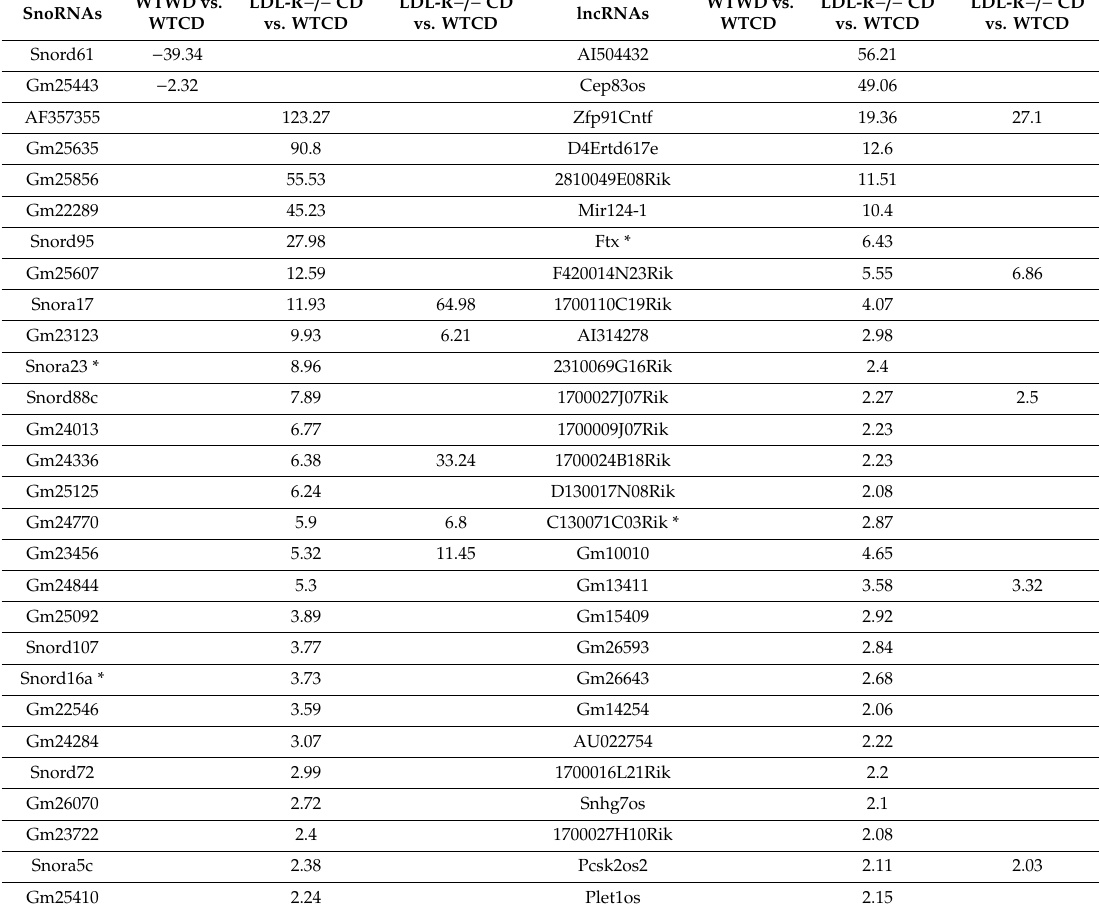
Table 1. E ff ect of the Western diet on the expression of small nucleolar RNAs (snoRNAs) and long non-coding RNAs (lncRNAs) in male hippocampal